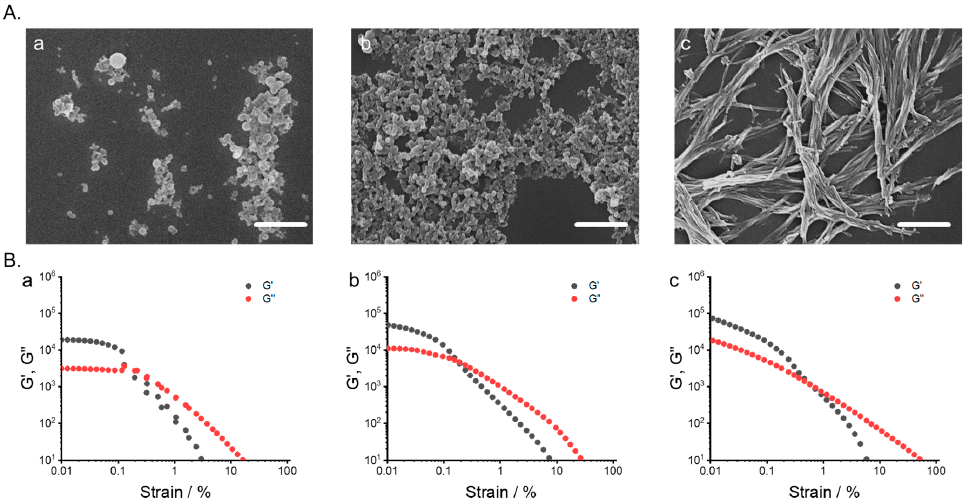
Figure 4. ( A ) SEM images of co-assembled supramolecular gel dependent on the ratio of compound 2 (scale bar, 1 μ m). ( B ) Rheological properties (G’ black dot; G’’ red dot) of co-assembled supramolecular gel dependent on the ratio of compound 2 . strain sweep tests at 0.001 % -100 %, [ 2 ]/[ 1 ] = ( a ) 0.2, ( b ) 0.5, and ( c ) 0.8 equivalents.